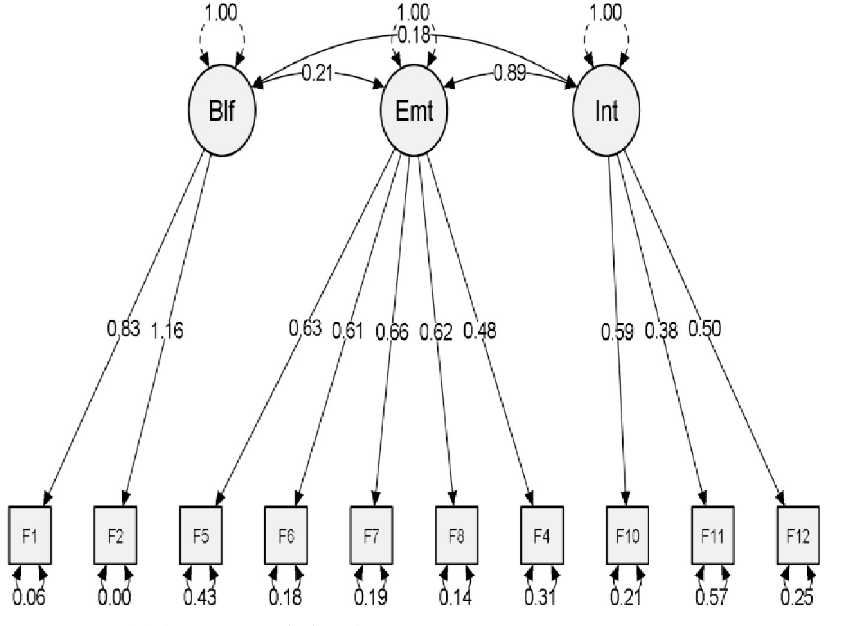
Fig 4. SEM model. (Source: own